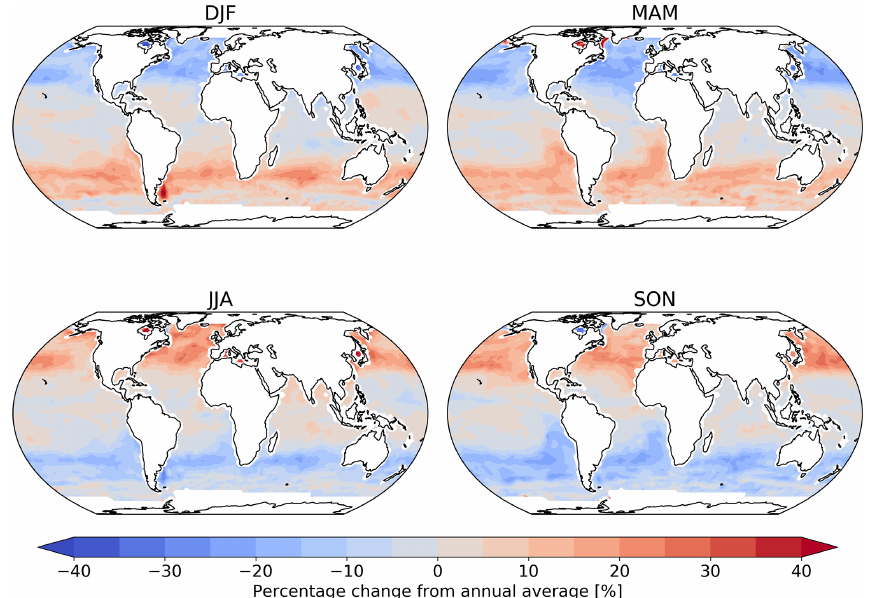
Figure 3. Percentage change from the annual mean deposition velocity for 2014 in December, January and February (DJF); March, April and May (MAM); June, July and August (JJA); and September, October and November (SON) for the new parameterization (shown in Fig. 2), demonstrating the deposition velocity responding to changes in sea-surface temperature and ocean I − concentration, with the lowest values of deposition velocity seen in the winter of each hemisphere. Land and ice grid boxes have been masked out.